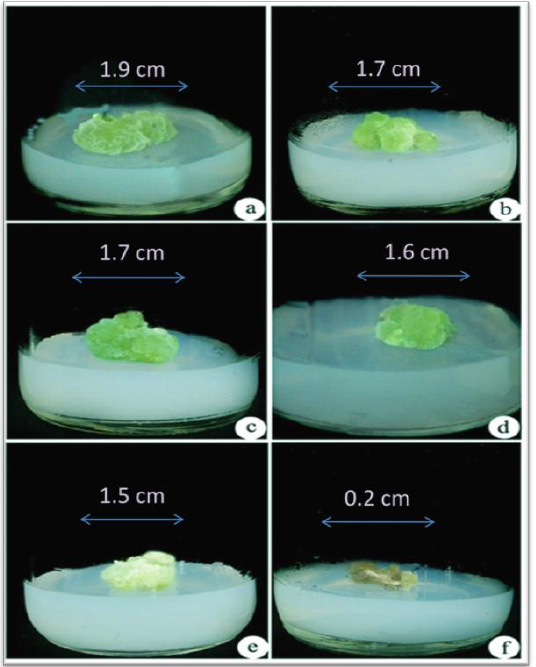
Figure 1. Assessment of NaCl tolerance in callus of A. vulgaris. ( a ) Control callus culture from (0 mM NaCl), ( b )callus cultured on (100 mM NaCl), ( c ) callus cultured on (200 mM NaCl), ( d ) callus cultured on (300 mM NaCl), ( e ) callus cultured on (400 mM NaCl) showed its growth reduction and discoloration, ( f ) dead calluses at (500 mM NaCl) concentration after 30 days.